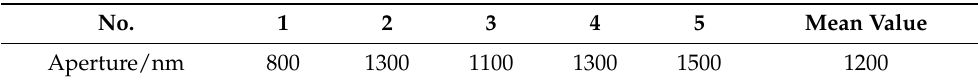
Table 4. Porosity in five groups of experiments.